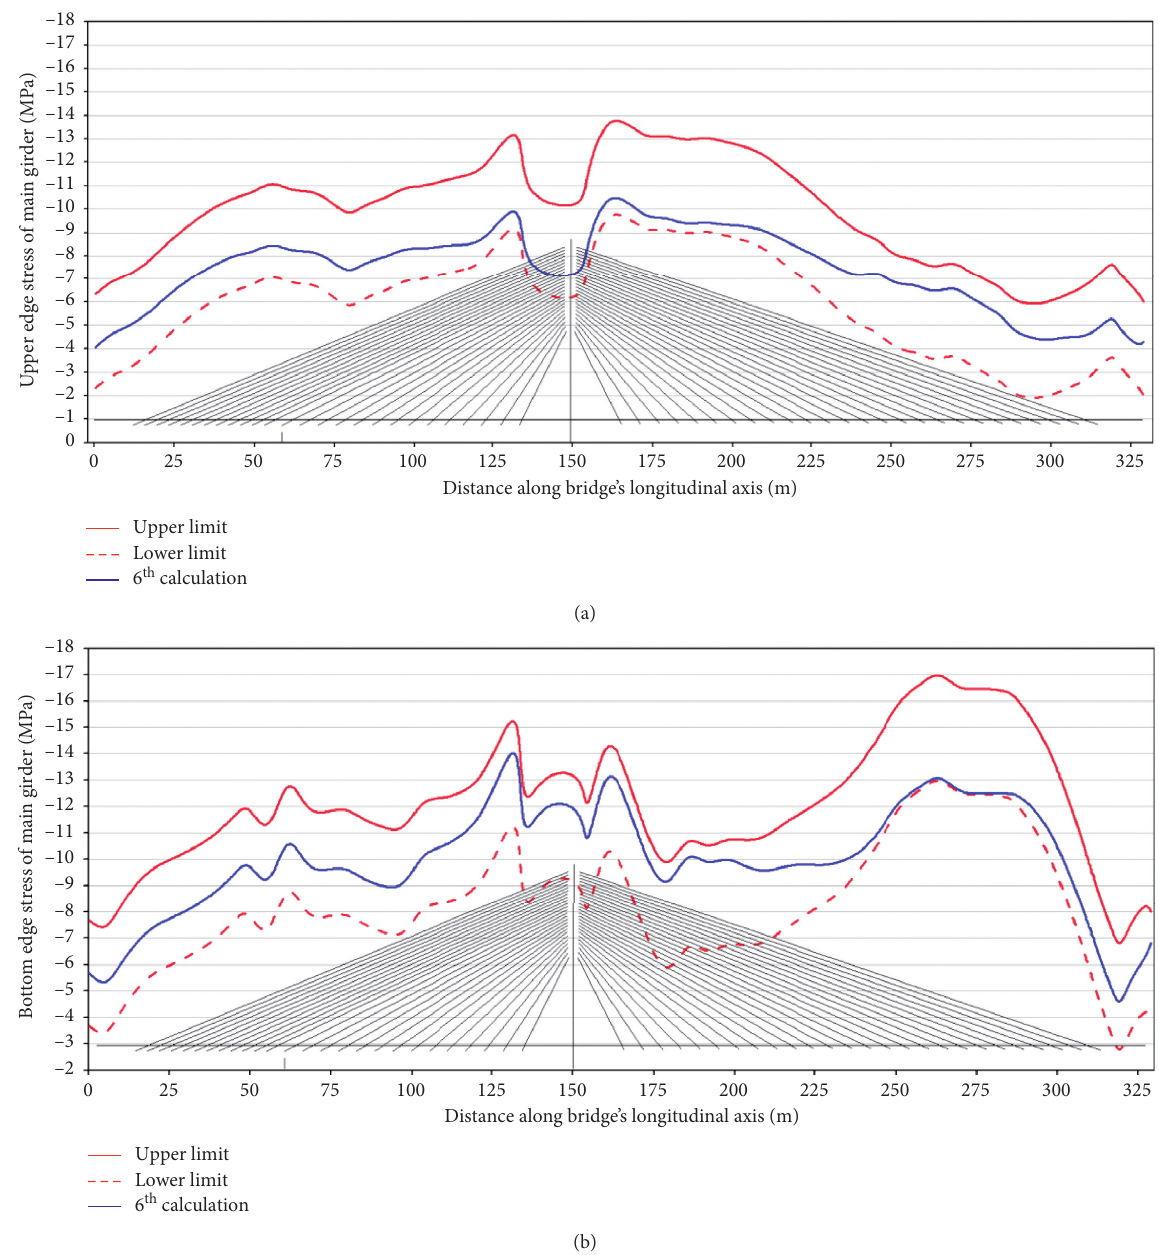
Figure 11: Stress state of the main girder at the completion of bridge. (a) Upper edge stress of the main girder. (b) Bottom edge stress of the main girder.